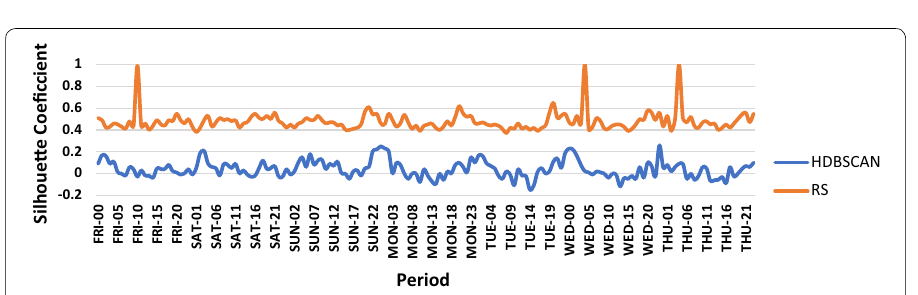
Fig. 6 Silhouette coefficient for trips